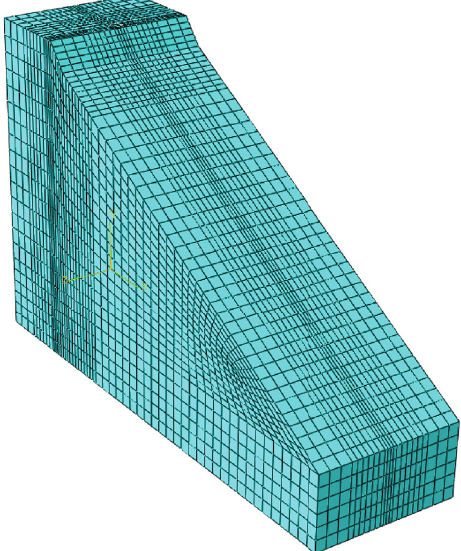
Figure 11: Three-dimensional model of concave